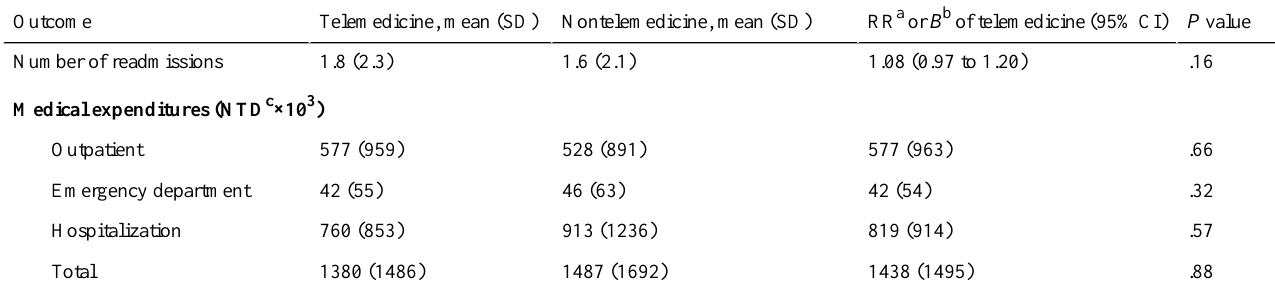
Table 3. Medical utilization and cost (after inverse probability treatment weighting) in patients with peripheral arterial occlusive disease who participated (n=162) and did not participate (n=229) in the telemedicine program after inverse probability treatment weighting..